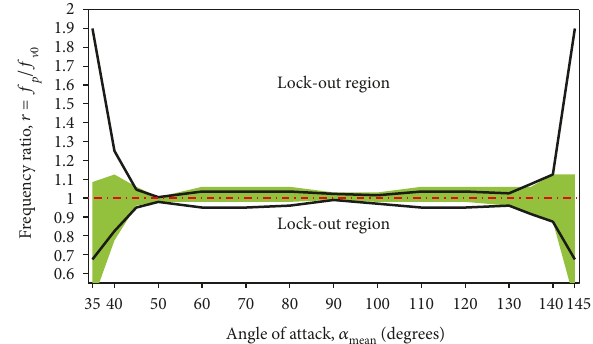
Figure 13: Proposed lock-in boundaries at α (in black line) and CFD model (in